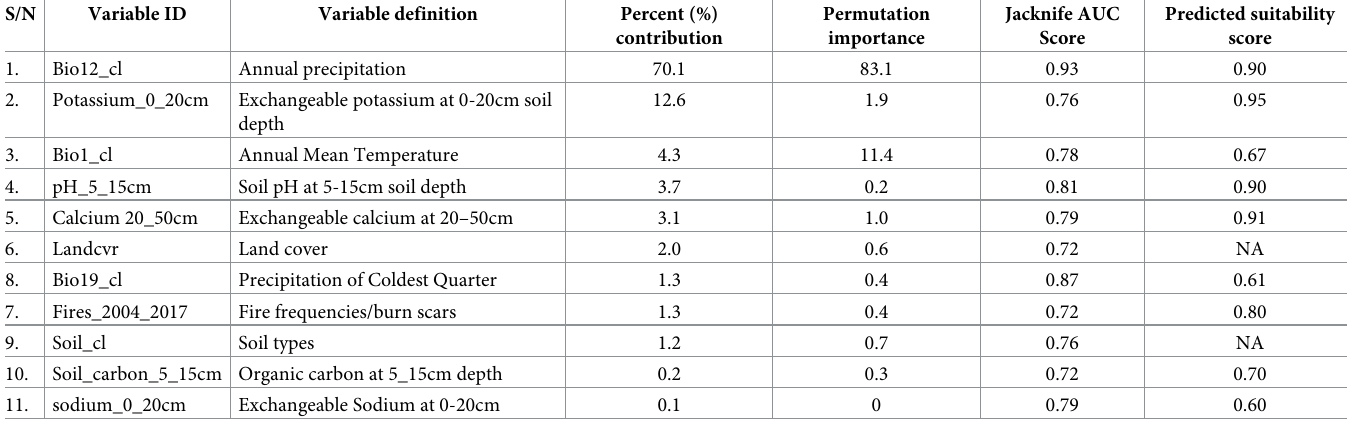
Table 4. Values measuring importance of variables in contributing to development and predictive power of the Maxent model for predicting suitable conditions for B . anthracis survival in